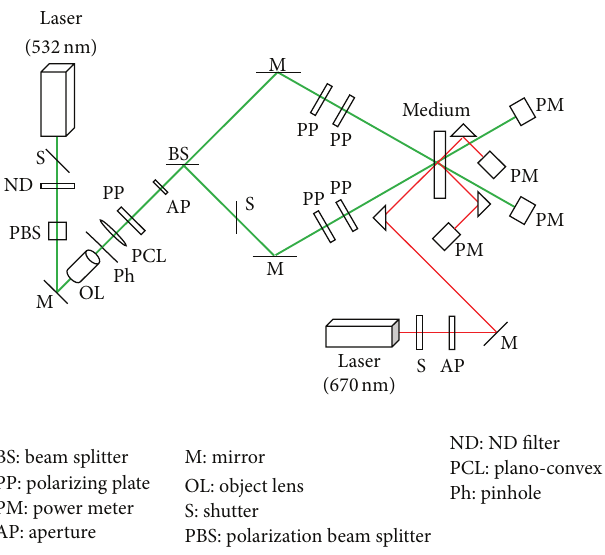
Figure 3: Experimental configuration.